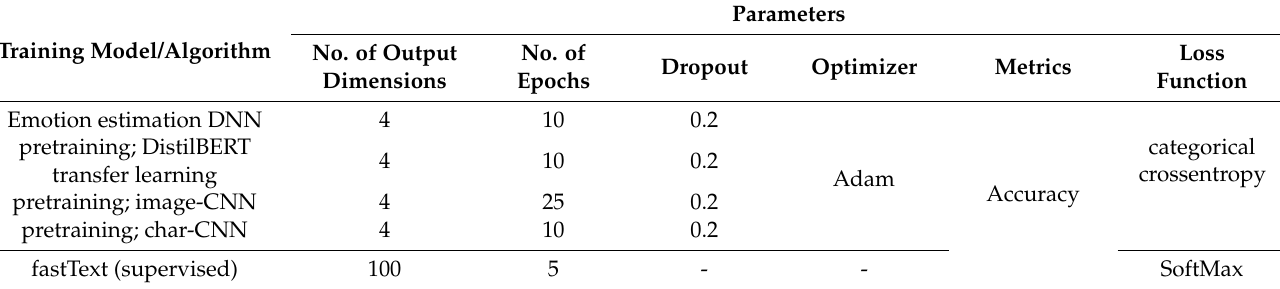
Figure 6. Network configuration of character-level CNN. Table 4. Parameters used for pretraining and training.